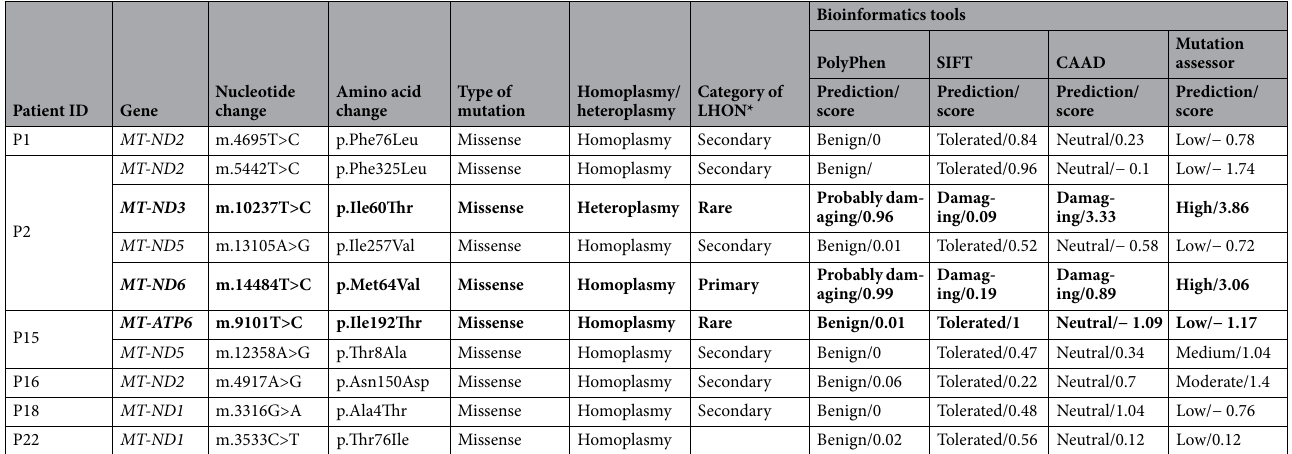
Table 2. LHON mtDNA mutations identified in RRMS patients and their deleteriousness prediction. LHON Leber’s hereditary optic neuropathy, RRMS relapse-remitting multiple sclerosis, EDSS